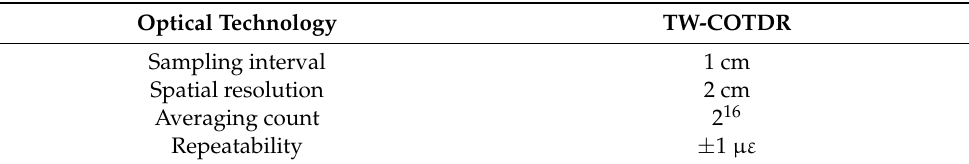
Table 3. Measurement parameters in the experiment.